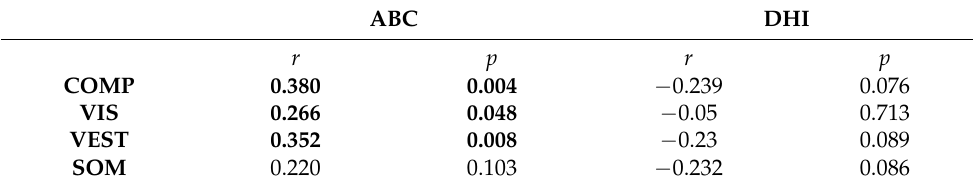
Table 4. Pearson’s correlation coefficients of self-reported and performance-based